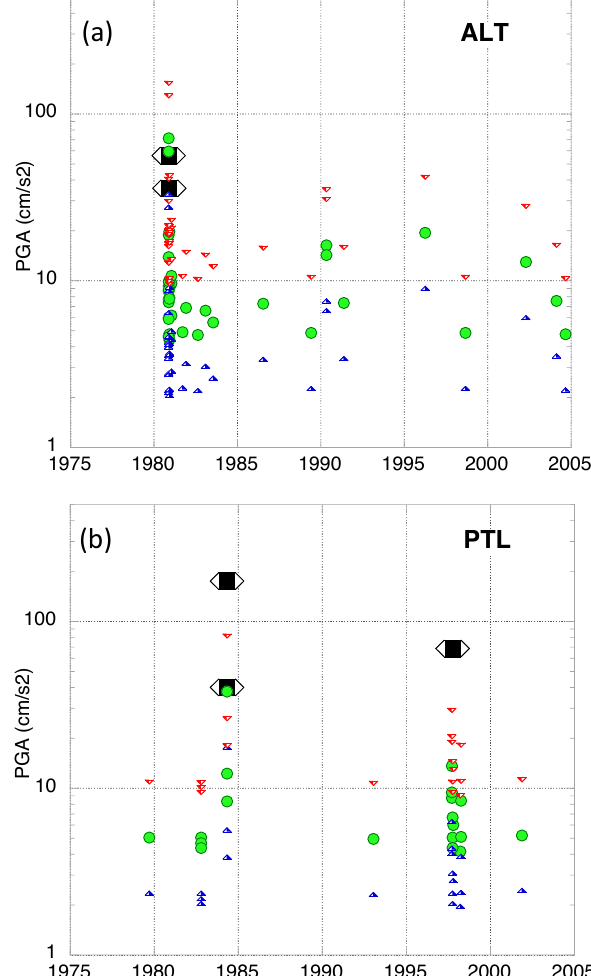
Figure 3. Observed and synthetic PGA values at two stations in the time span 1975–2004. The observed data are plotted by b/w sym- bols (values as reported in ITACA 1.1. database and in Pacor et al., 2013); the computed PGA values represented respectively by green circle (mean), red and blue triangles ( ± 1 standard deviation), have been obtained by ITA10 GMPE applied to the CPTI11 earthquake catalogue; synthetic PGA are plotted only if the red triangle (mean PGA + 1s) is greater than 0.01g, common triggering threshold of that time, as chosen in Fig. 1. (a) Auletta station ALT (Salerno, in southern Apennines); (b) Pietralunga station PTL (Perugia, Central Italy).